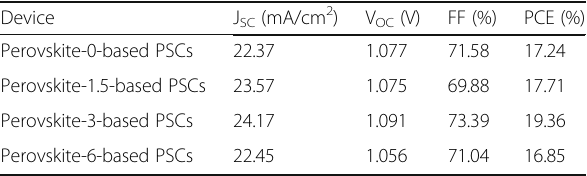
Table 1 Photovoltaic parameters of the champion device in each group Device J SC (mA/cm 2 ) V OC (V) FF (%) PCE (%) Perovskite-0-based PSCs 22.37 1.077 17.24 Perovskite-1.5-based PSCs 23.57 Perovskite-3-based PSCs Perovskite-6-based